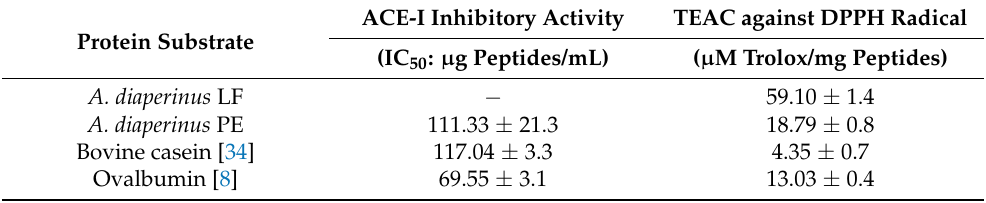
Table 3. Antioxidant activity against DPPH radical and ACE-I inhibitory activity of different pro- tein substrate hydrolysates (bovine casein and ovalbumin) obtained with water-soluble enzymatic artichoke extract in comparison with the A. diaperinus total larvae flour (LF) and its protein extract (PE)